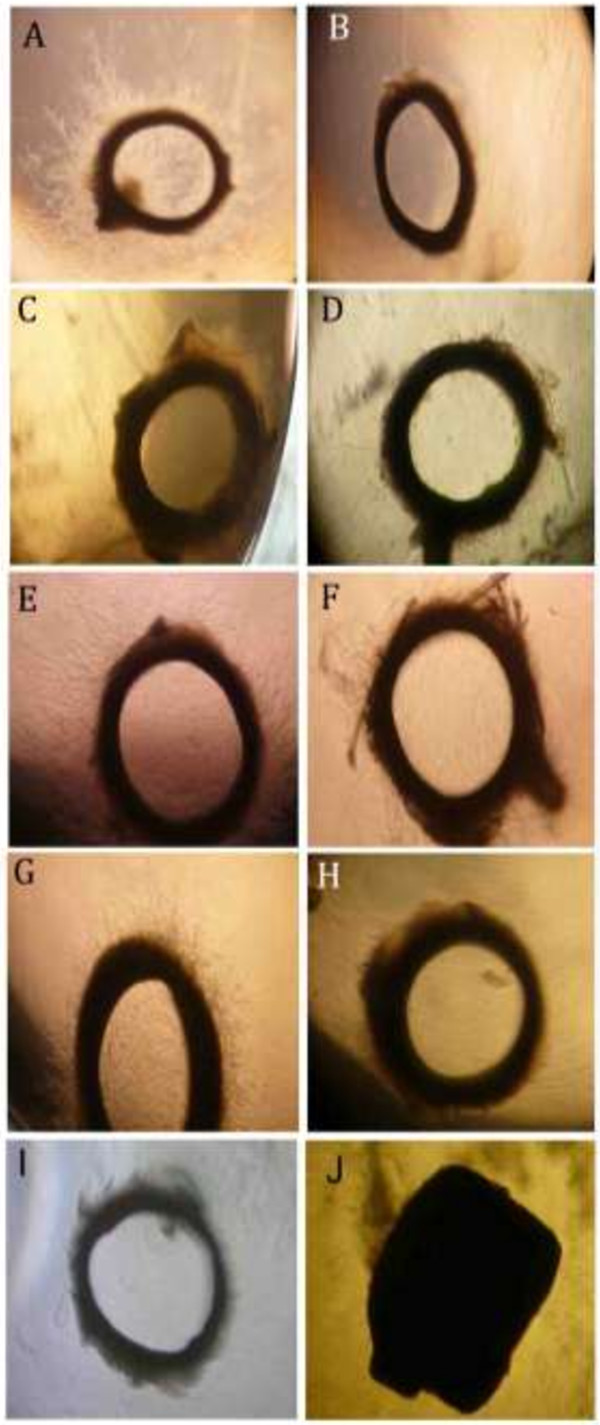
Effect of selected plant extracts on rat aortic vessel outgrowth. (A) negative control (B) positive control (Suramine) (C, D) 50 and 100 μg/mL of S. dominica(E, F) 50 and 100 μg/mL of S. hormium,(G, H) 50 and 100 μg/mL of S. triloba and 50 and 100 μg/mL of S. syriaca(I, J).